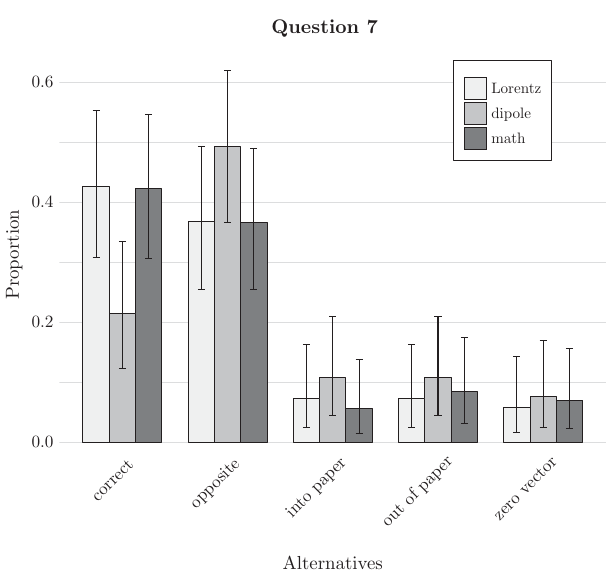
FIG. 7. Students ’ answers on question 7 where the direction of first factor of the cross product was sought. Error bars indicate the 95% confidence intervals based on the Clopper-Pearson